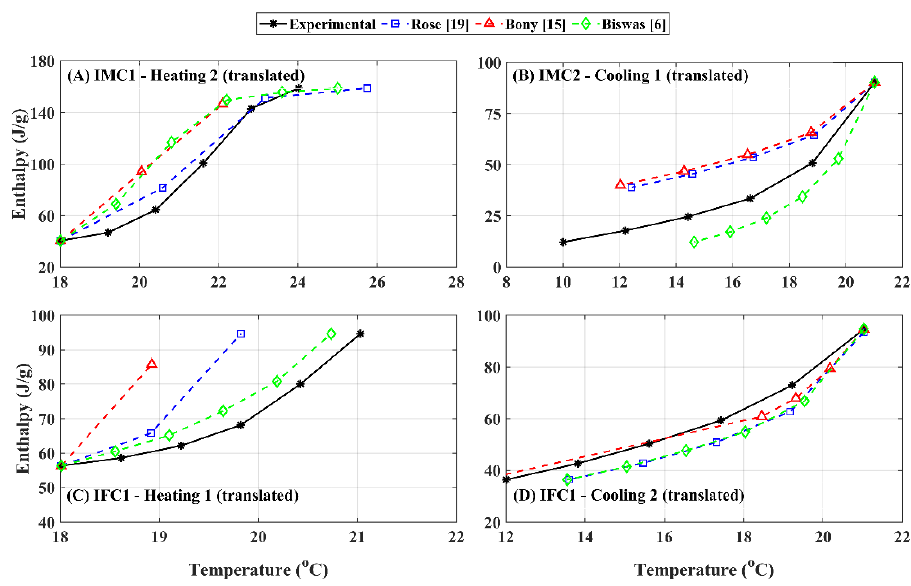
Figure 10. Translated cooling and heating curves. ( A ) Heating 2 during test IMC1; ( B ) Cooling 1 during test IMC2; ( C ) Heating 1 during test IFC1; and ( D ) Cooling 2 during test IFC1.